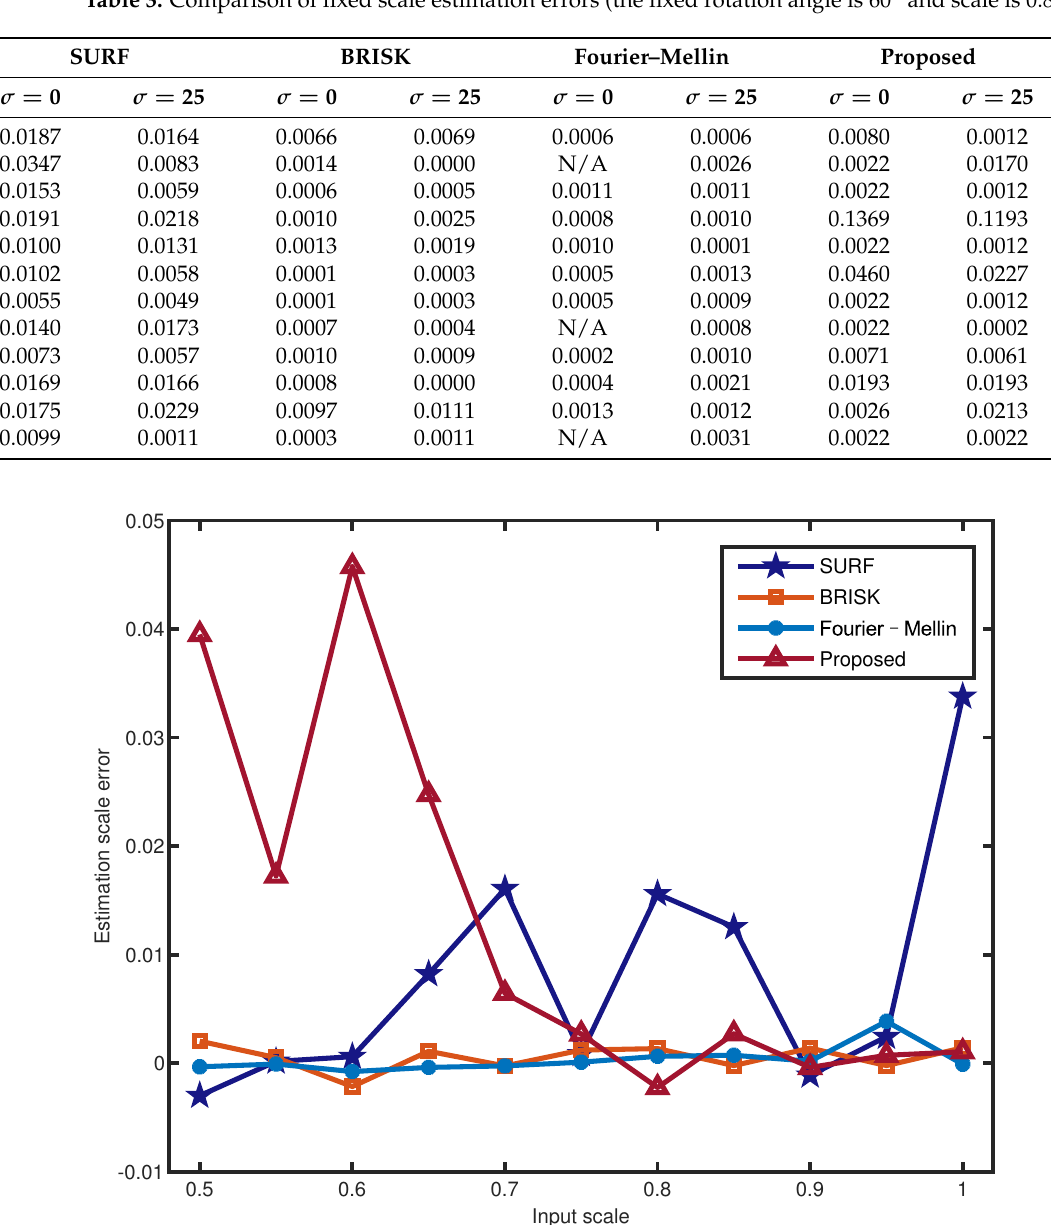
Figure 8. Scale estimation errors for different input scales of the Lena image with σ =